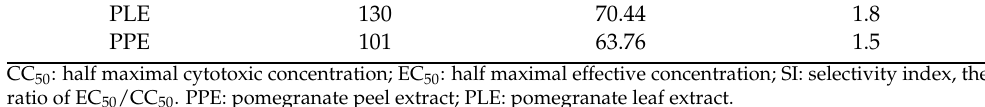
Table 3. Selectivity index (SI), cytotoxicity (CC 50 ), and antiviral activity (EC 50 ) of PLE and PPE.